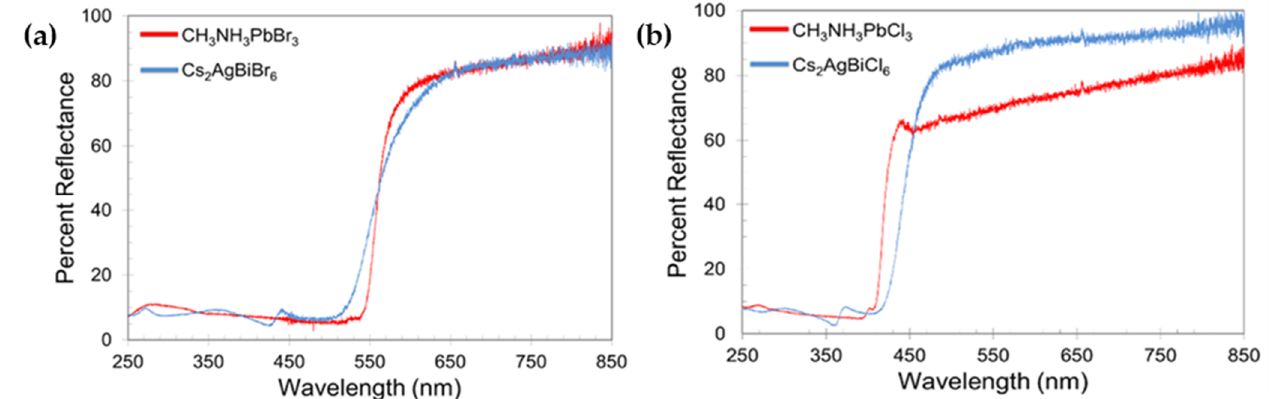
Figure 5. Diffuse reflectance spectra of; ( a ) MAPbBr 3 and Cs 2 AgBrBr 6 ; ( b ) MAPbCl 3 and Cs 2 AgBrCl 6 . Reproduced with permission from [49]. Copyright 2016, American Chemical Society.